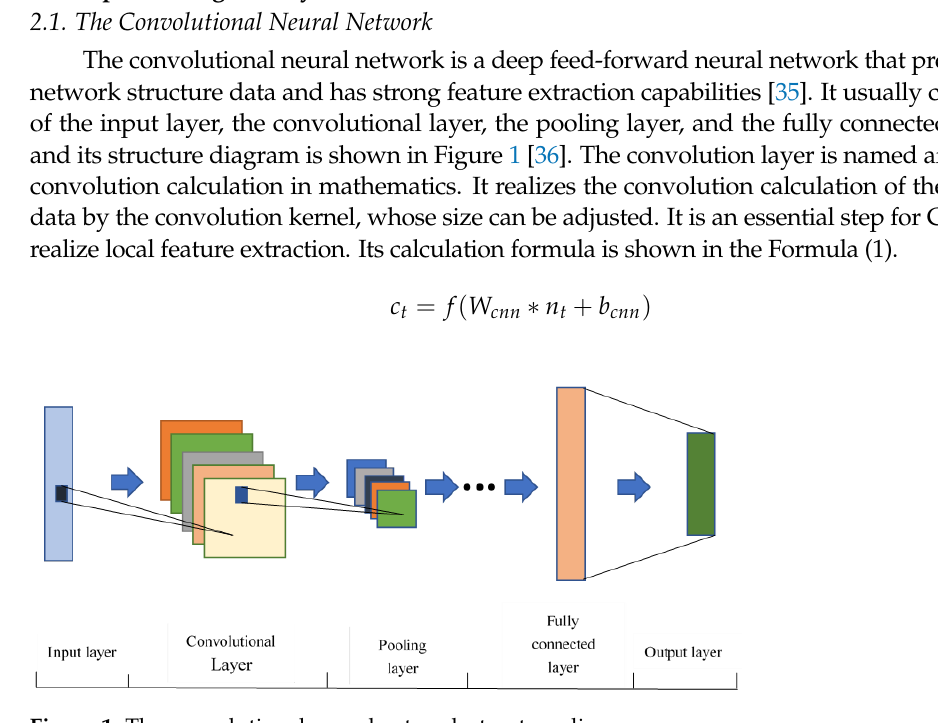
Figure 1. The convolutional neural network structure diagram.